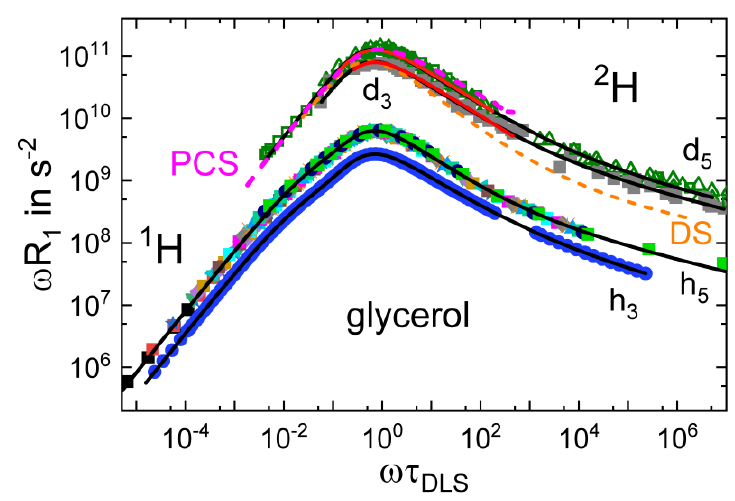
Figure 2. Susceptibility master curves as a function of ωτ DLS ( T ) ( τ DLS data from ref. [28]). The plot includes 1 H FC data for glycerol-h 3 (blue closed circles) [36] and glycerol-h 5 (multi-coloured data) [36], and high-field 2 H spin-lattice relaxation data for glycerol-d 3 (dark green) and glycerol-d 5 (grey) recorded at 55 MHz (squares) and 40 MHz (triangles) [78]. The master curves include results at temperatures from 180 K to 360 K, the dielectric spectrum at 288 K (orange dashed line) [79], and the PCS spectrum at 220K (magenta dashed line). Black lines represent fits with a model featuring translational and reorientational contributions (see text) for 2 H data with reorientational contribution only. Red lines show a fit of the maximum region with a single CD function, yielding a stretching parameter β CD ≈ 0.47 ± 0.03 .